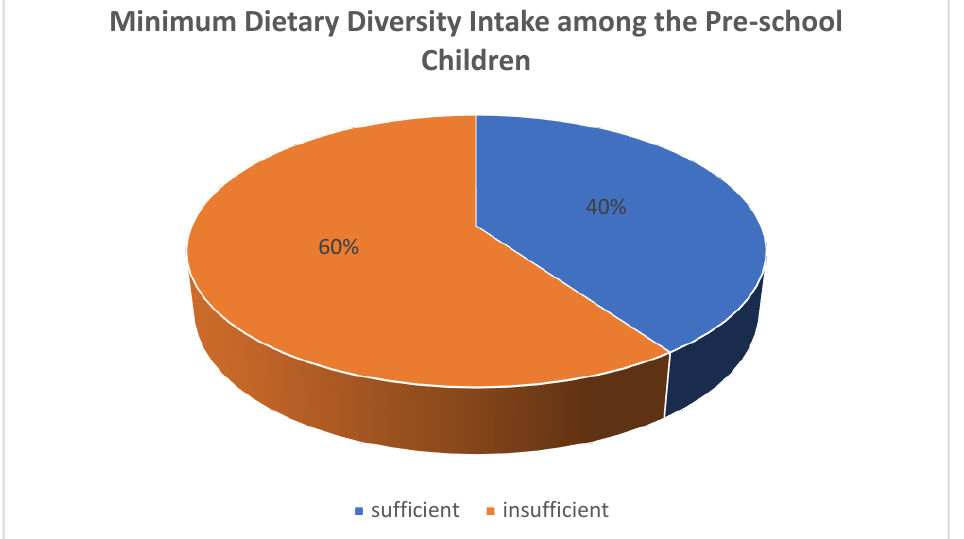
Figure 4. Proportion of preschool children meeting their minimum dietary diversity (MDD).